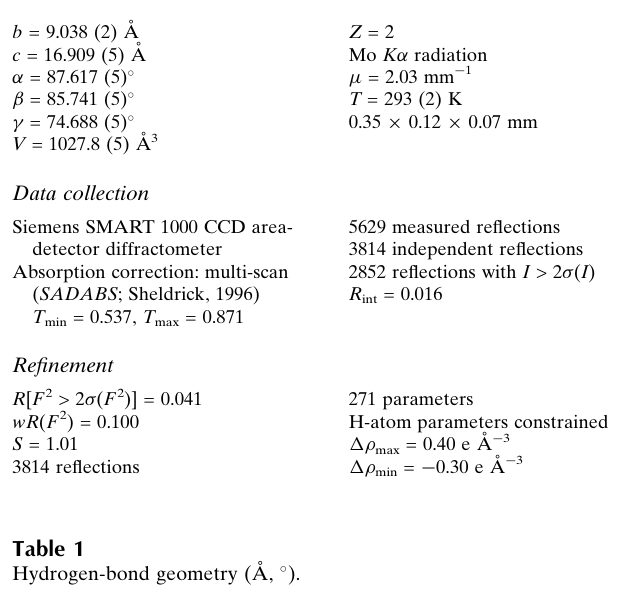
Hydrogen-bond geometry (A˚ , (cid:1)